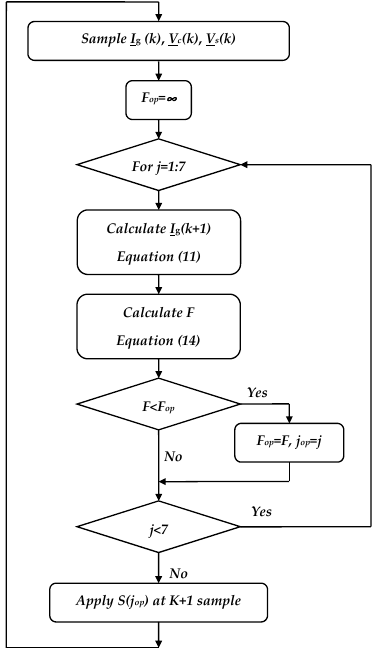
Figure 7. MPC algorithm flowchart.